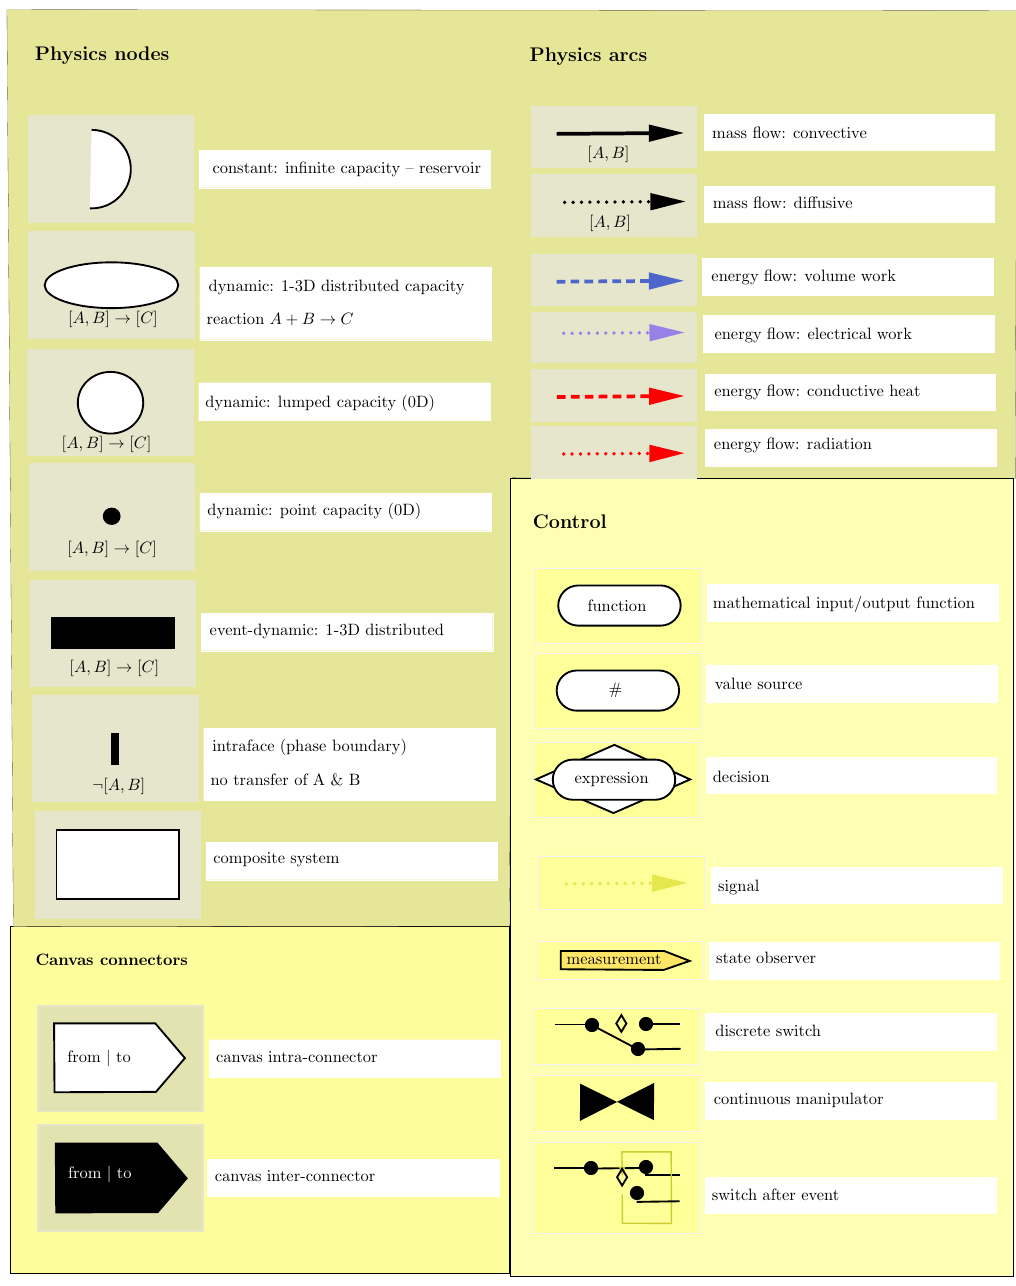
Figure A1. A starter set of graphical symbol defining the graphical modelling